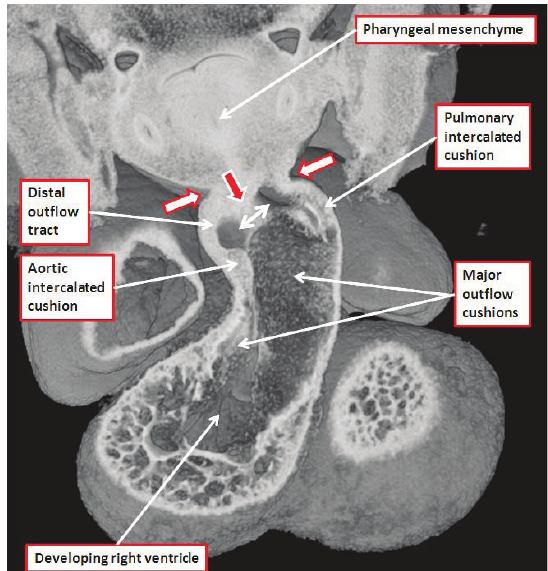
Figure 7. The image is a section through an episcopic dataset prepared from a developing mouse at E11.5. The cut passes through the long axis of the dogleg bend within the outflow tract, and shows how the intercalated cushions are appearing at the inner and outer angles of the dogleg. Note that the walls of the distal outflow tract merge with the pharyngeal mesenchyme at the margins of the pericardial cavity (white arrows with red borders), and that a ventral protrusion from the dorsal wall of the aortic sac is growing toward the distal aspects of the major outflow cushions (red arrow with white borders). The space between the protrusion and the cushions is the embryonic aortopulmonary foramen. The major outflow cushions, still to fuse at this stage, spiral through the intermediate and proximal parts of the outflow tract. The section has largely bisected the septal cushion. Note that the arrow identifying the pharyngeal mesenchyme points also to the developing trachea, which develops in the central part of the